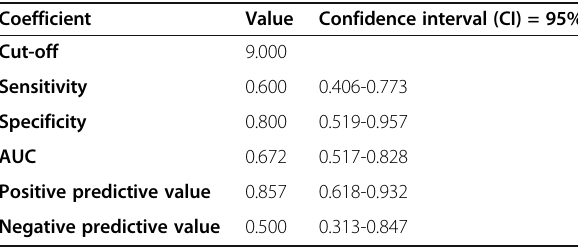
Table 6 Predictive value of QTd to detect IHD